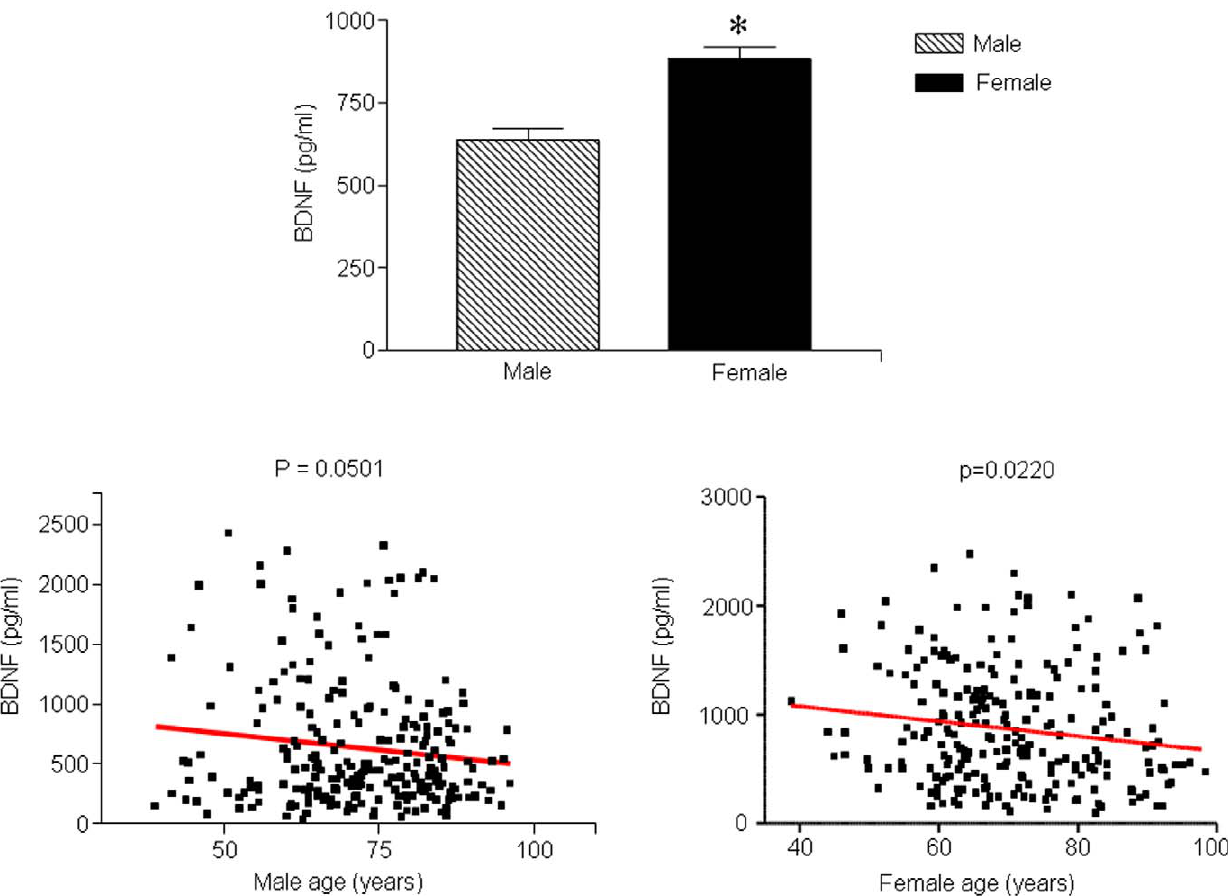
Figure 1. Plasma BDNF, gender and age. A. Plasma BDNF was significantly higher in females than in males (p , 0.05). B and C. Multiple linear regression revealed that plasma BDNF was inversely correlated with age in males (p=0.0501, R 2 =0.01577) and in females (p=0.0220, R 2 =0.02244).